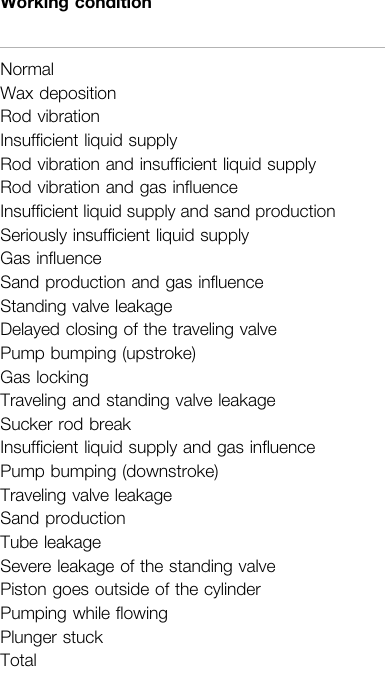
TABLE 5 | Classi fi cation of the working conditions and the number of samples for each working condition. Working condition